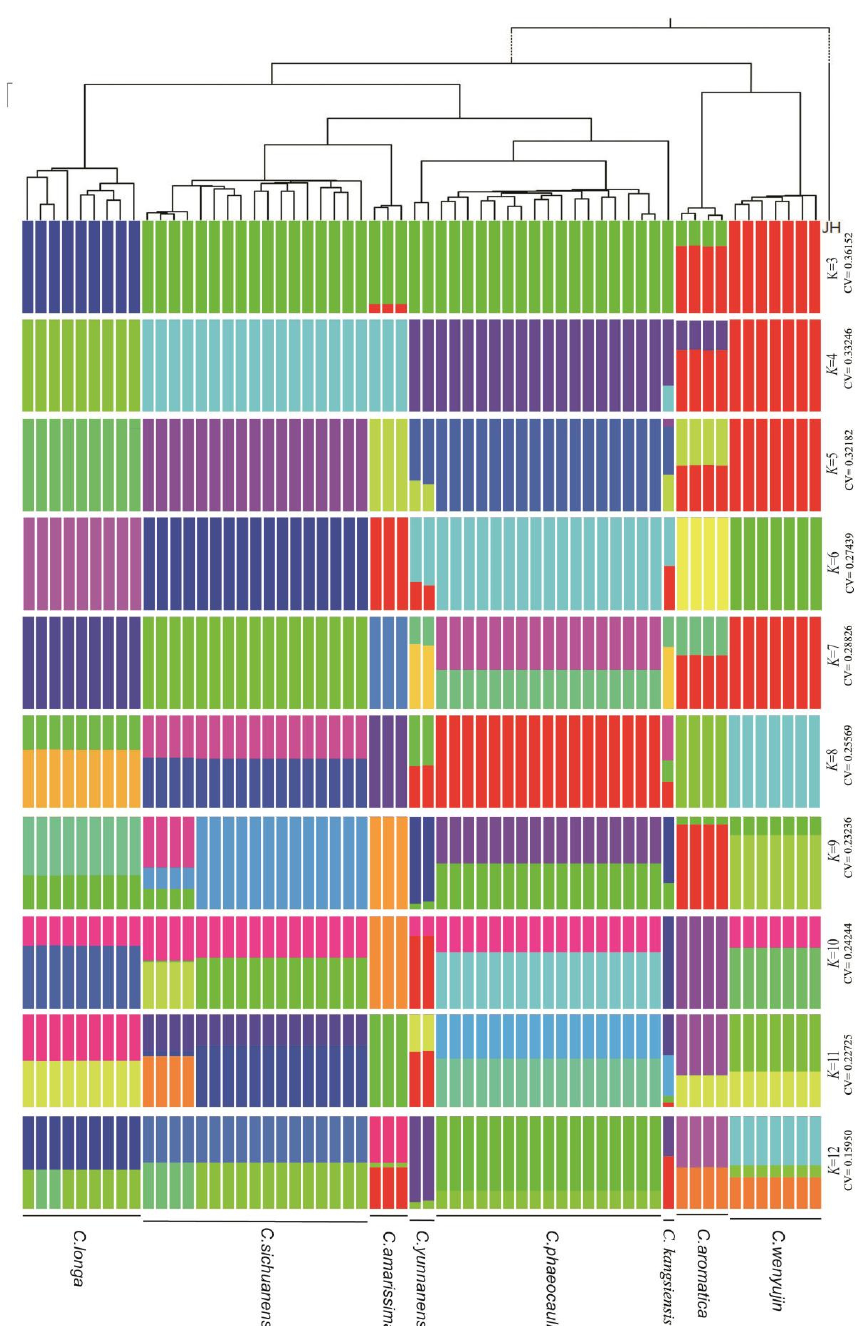
Figure 3. Population genetic structure of Chinese Curcuma . When the kinship ( K ) = 3–12, each vertical bar represented a Curcuma sample and different color represented different putative ancestral background in putative.